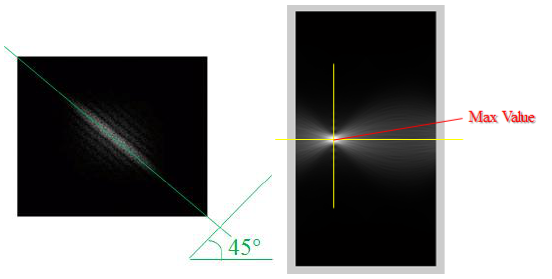
Figure 13. The result of Fast Fourier (left) and Radon Transform (right) on the image